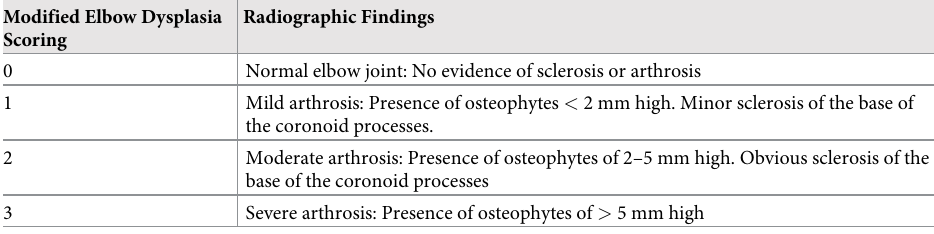
Table 1. Modified elbow dysplasia scoring—screening for elbow dysplasia, grading according to the IEWG Dr. H. A.W. Hazewinkel [2].